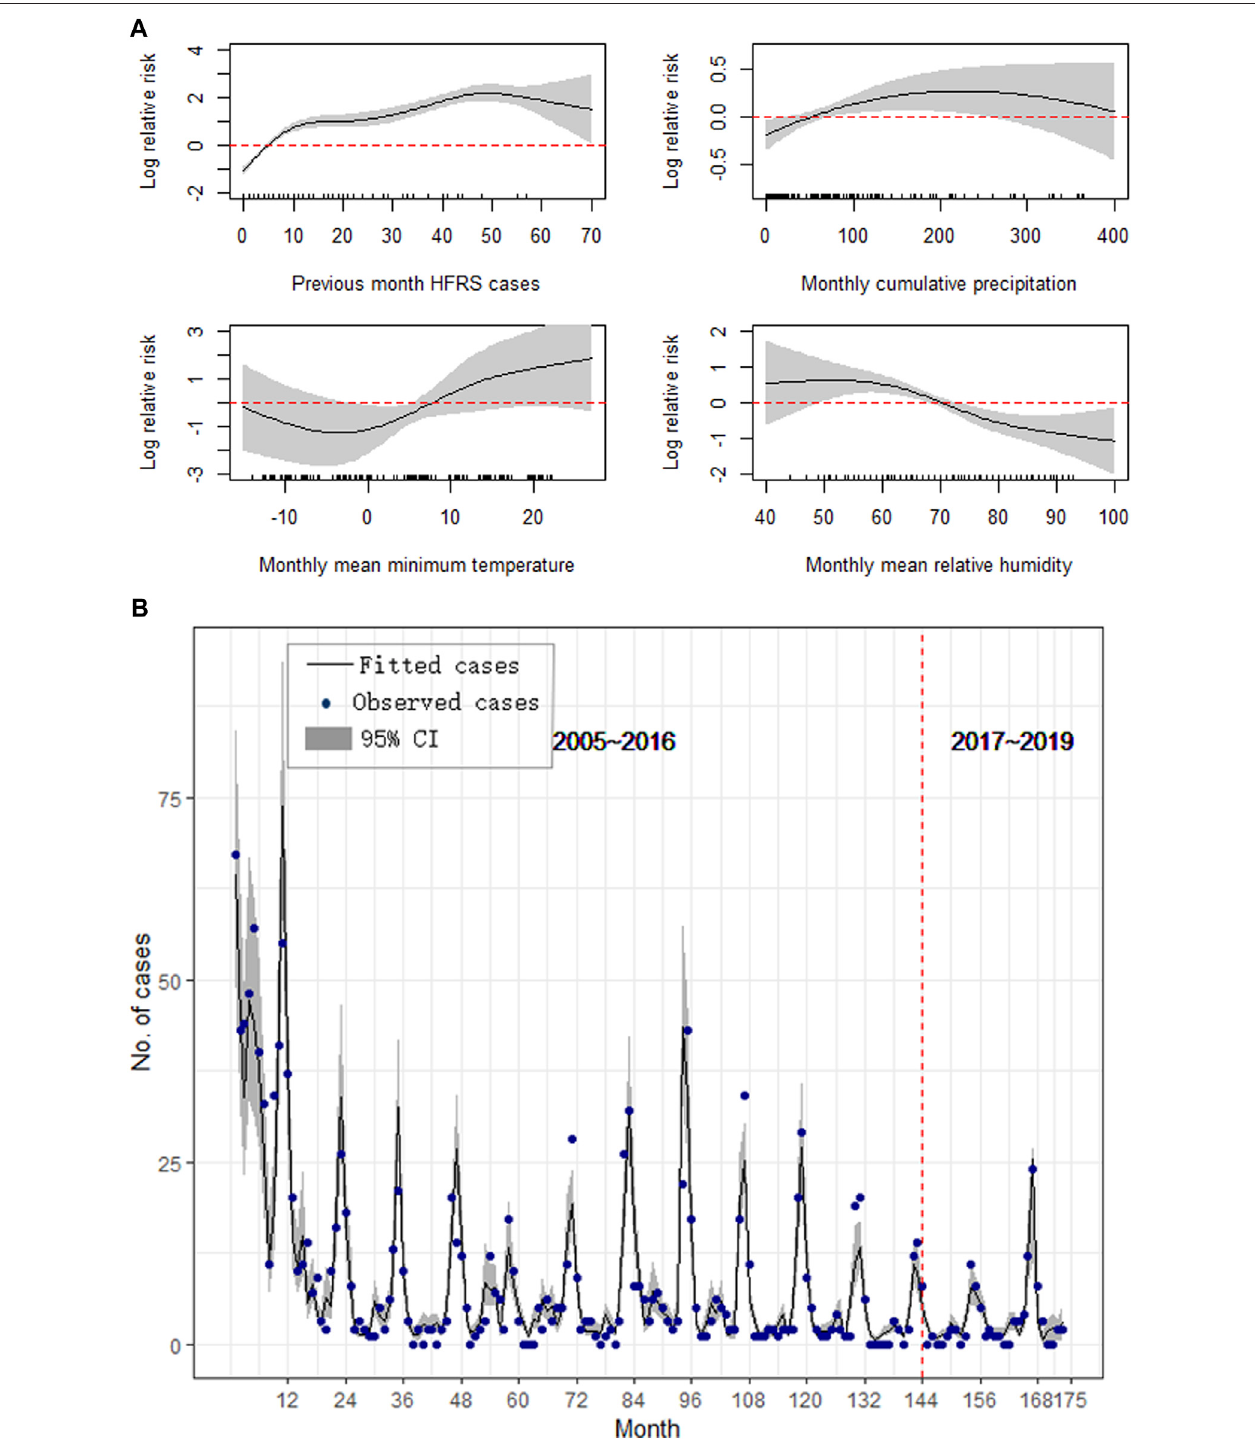
FIGURE 3 | Results of the GAM for Dandong. (A) The effect of meteorological on the epidemics of HFRS, (B) Forecast and comparison of the fi tted values.